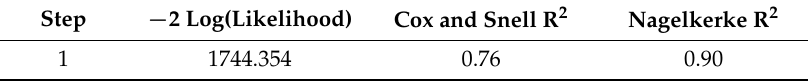
Table 4. Goodness-of-fit statistics of the logistic regression in the study area.